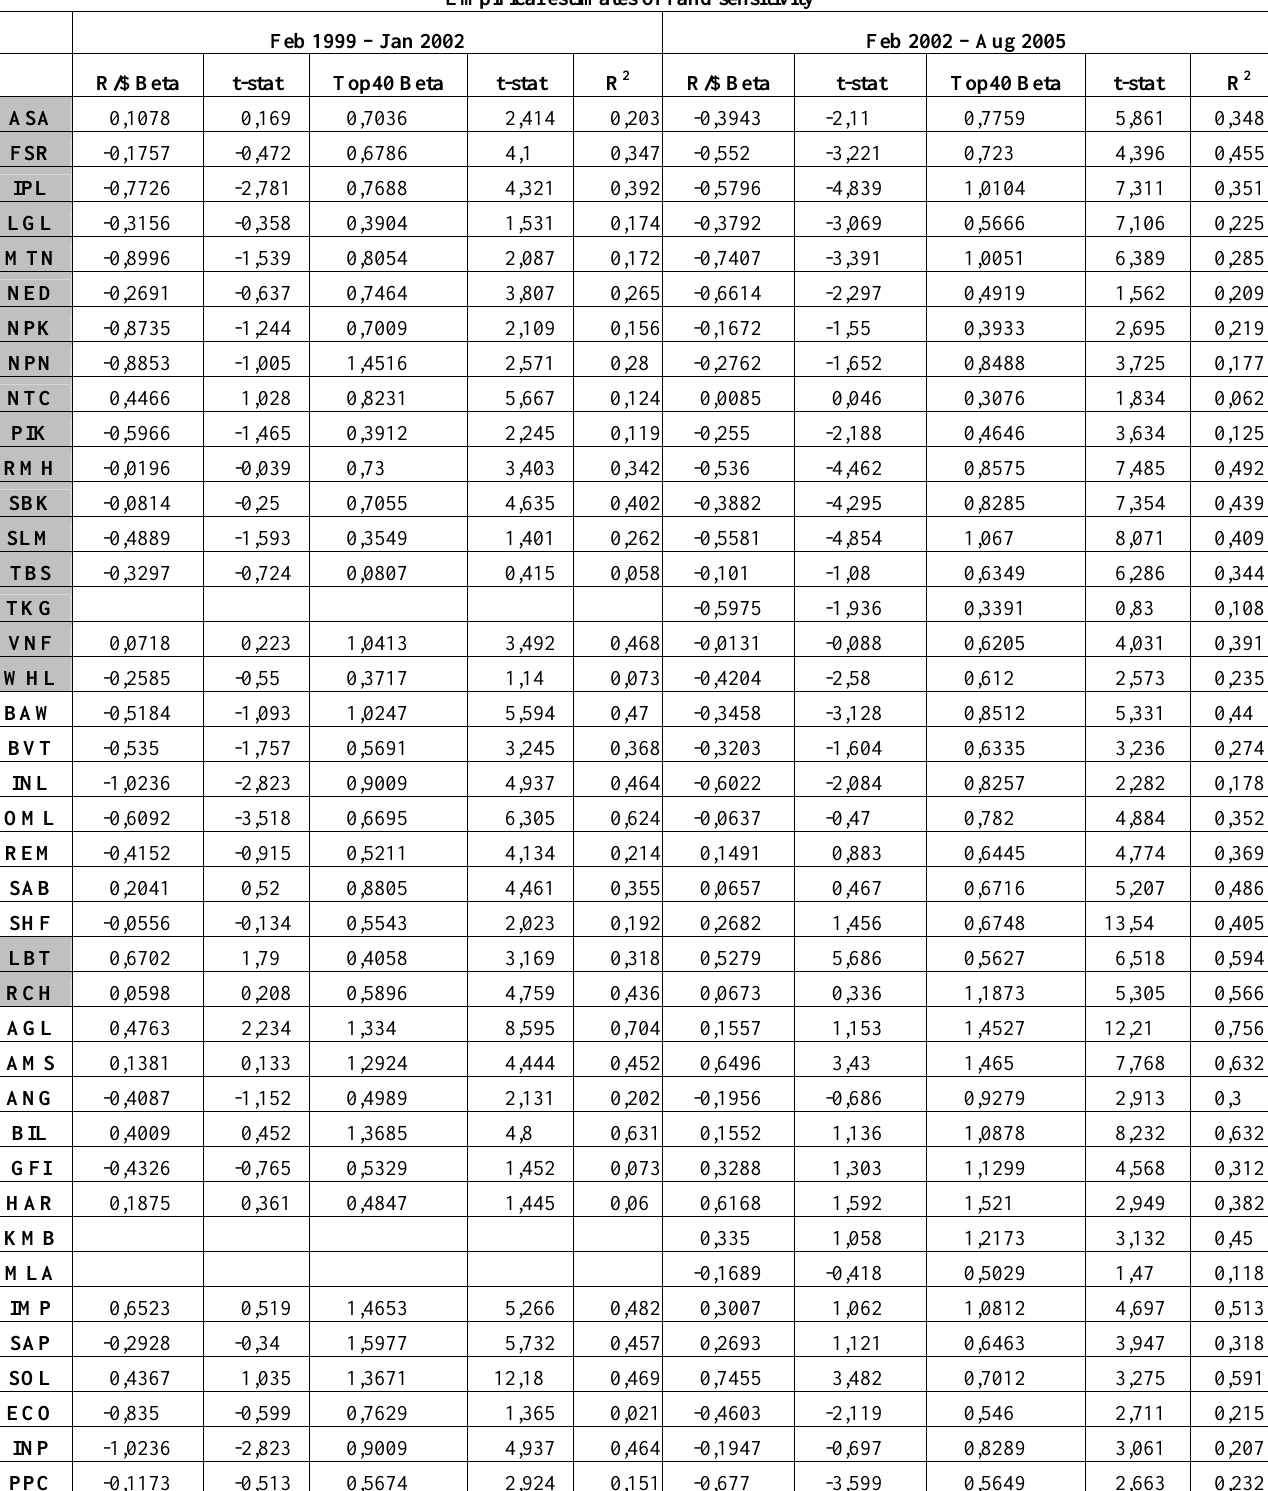
Table 2: Empirical estimates of rand sensitivity using a GARCH(1,1) adjustment Empirical estimates of rand